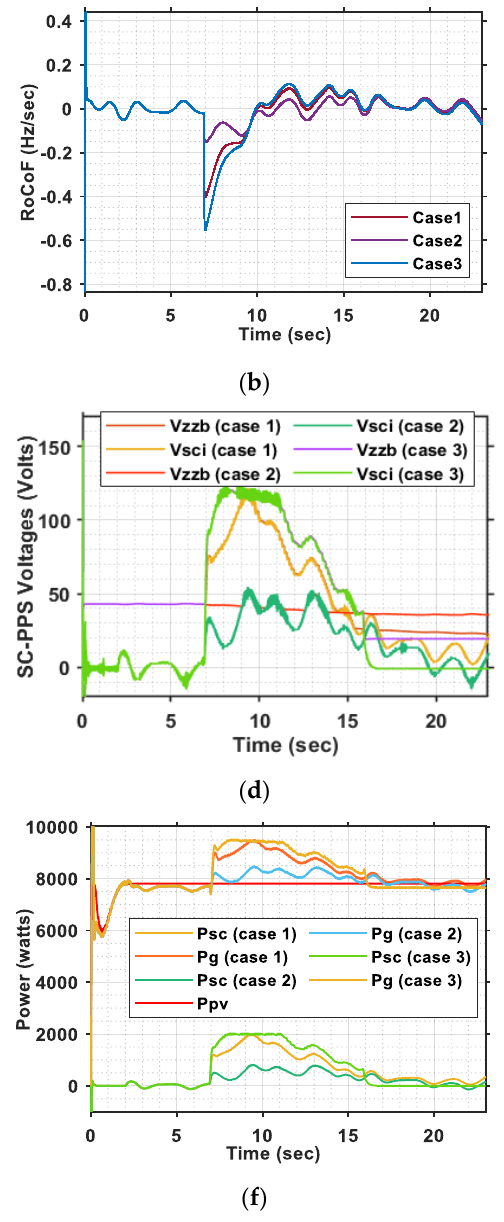
Figure 23. MATLAB simulation results for PFR based on various case studies with low-frequency fluctuation: ( a ) under- frequency event profiles; ( b ) RoCoF subjected to variations in frequency; ( c ) variation in SC voltage; ( d ) voltage profiles of the SC-PPS; ( e ) PV current and average current of SC; ( f ) PV, SC and grid power profiles. Table 7. Case Studies for PFR with low-frequency fluctuation in the PFR